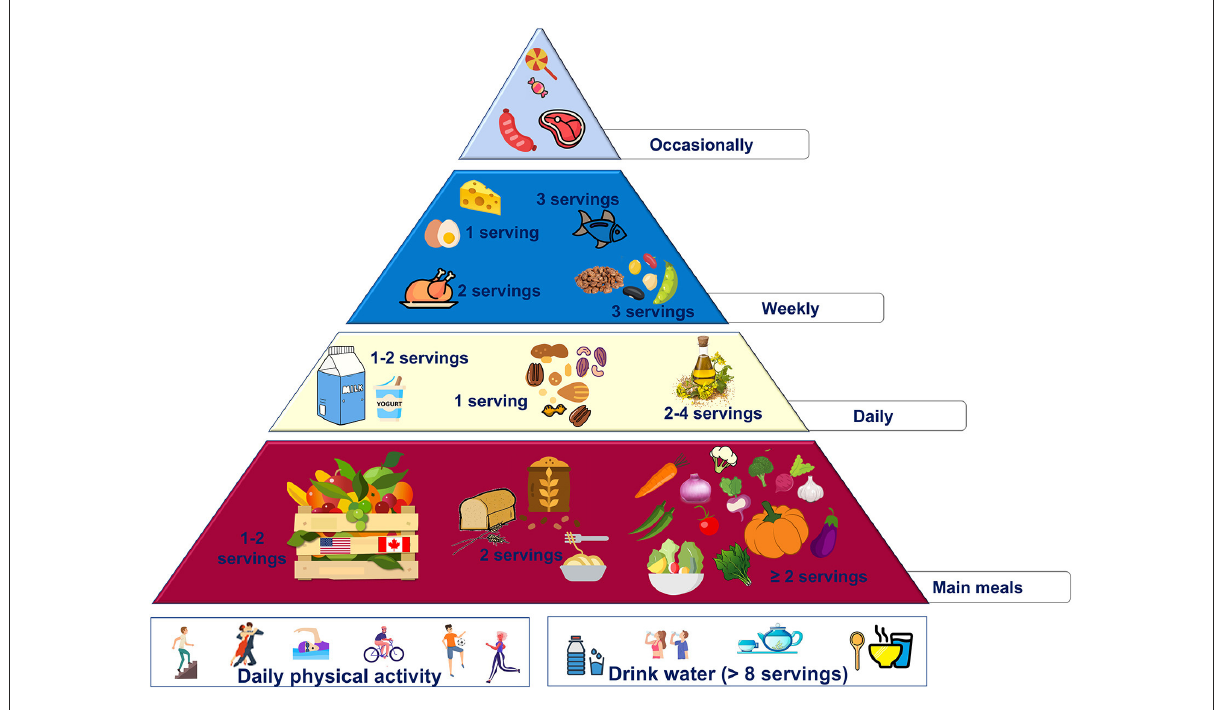
FIGURE1 Proposed nutritional pyramid for North